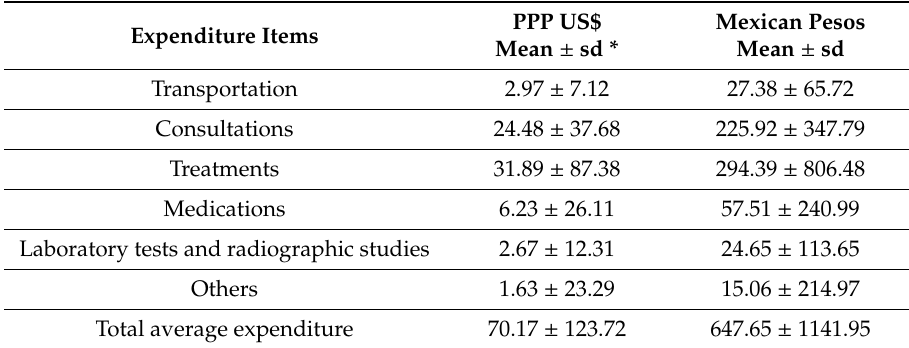
Table 3. Out-of-pocket expenditures on dental care in the school sample and their distribution by type of expense, International Dollars and Mexican Pesos,